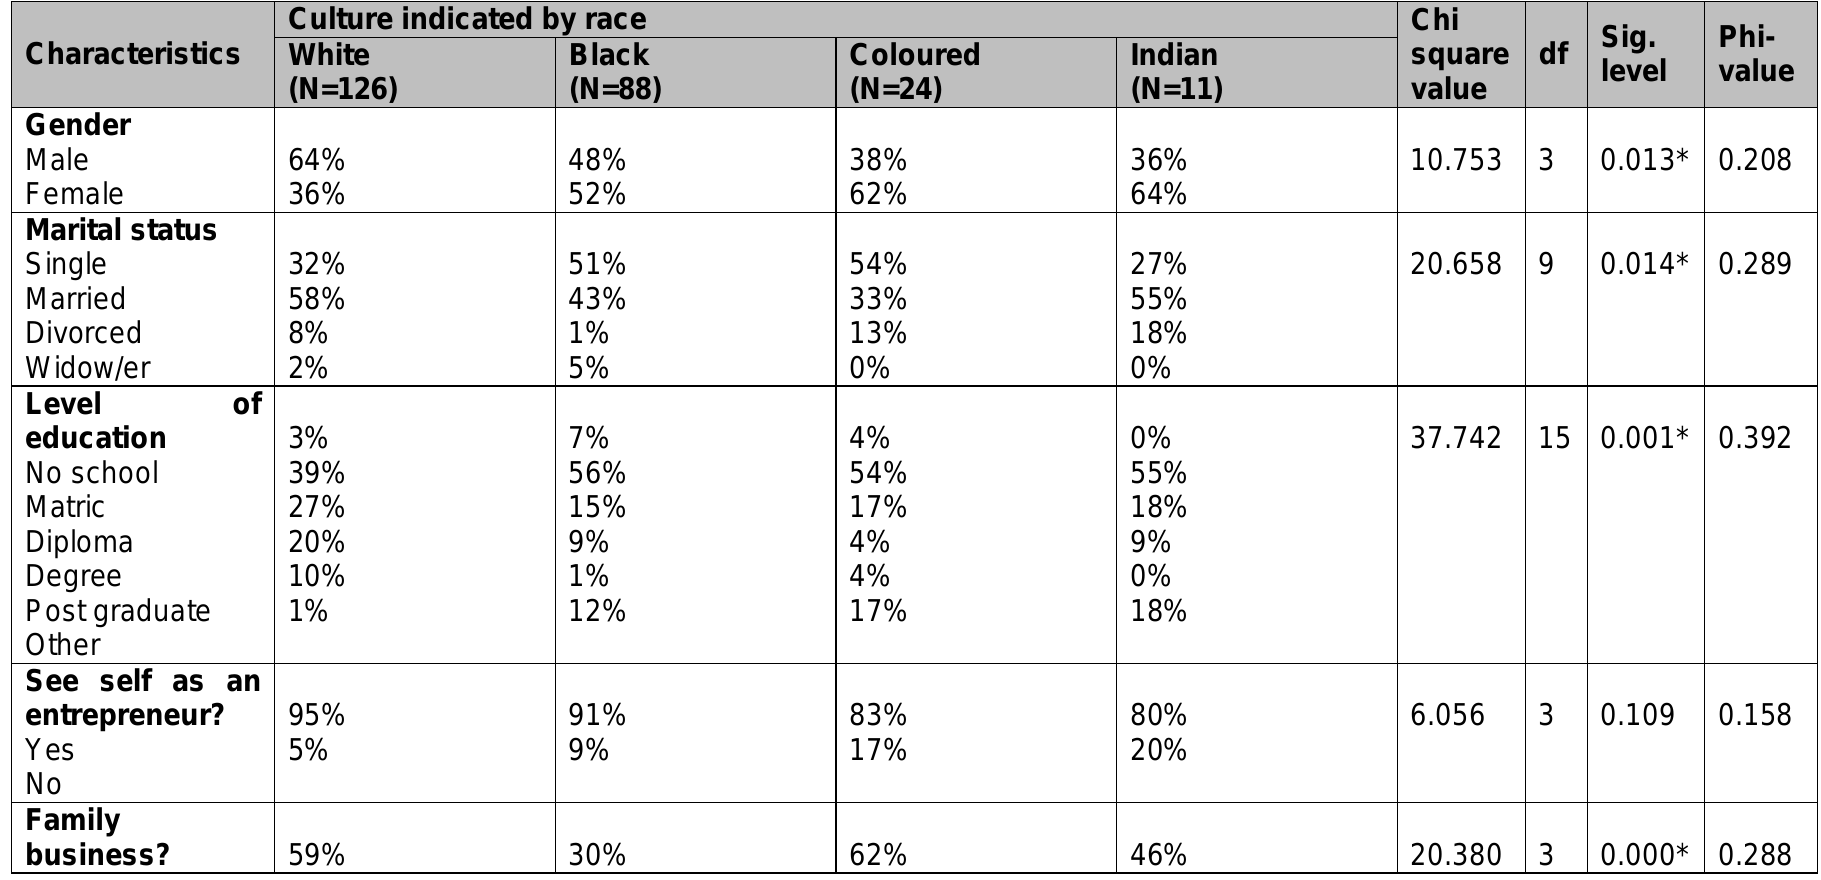
Table 6: Chi-square test results of visitor characteristics between different cultures